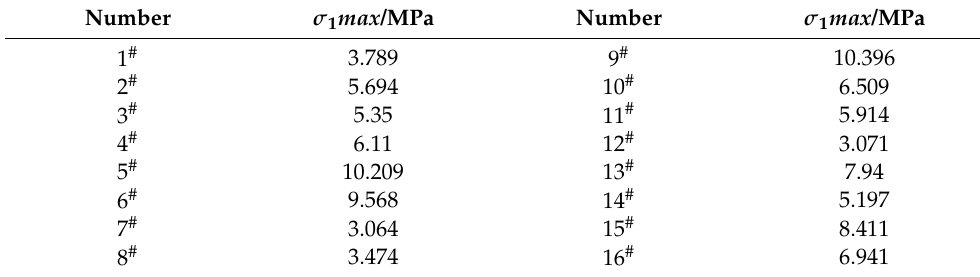
Table 4. True triaxial test results for saline calcareous clay.